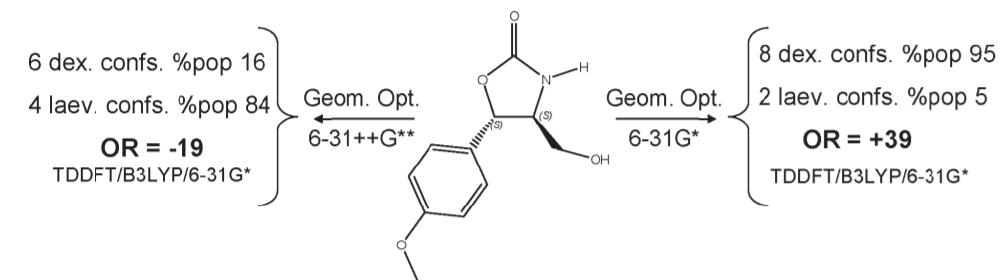
Figure 16. Dependence of predicted sign and magnitude of ORD for isocytoxazone based on on conformational distribution and TDDFT basis set level of theory [63].